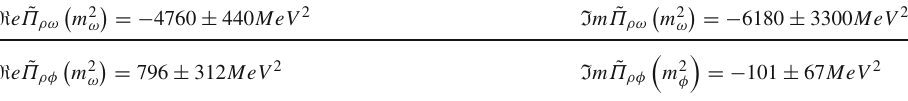
Table 1 The value of the mixing